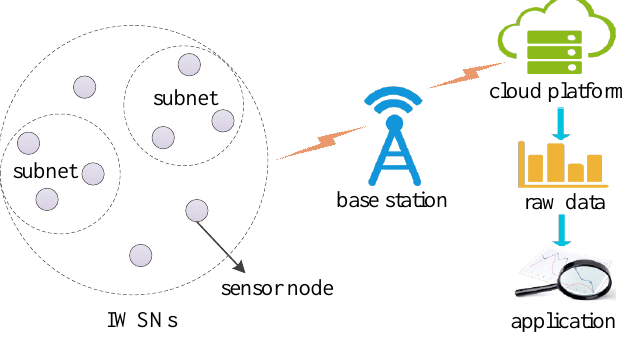
Figure 1. Illustration of node location data